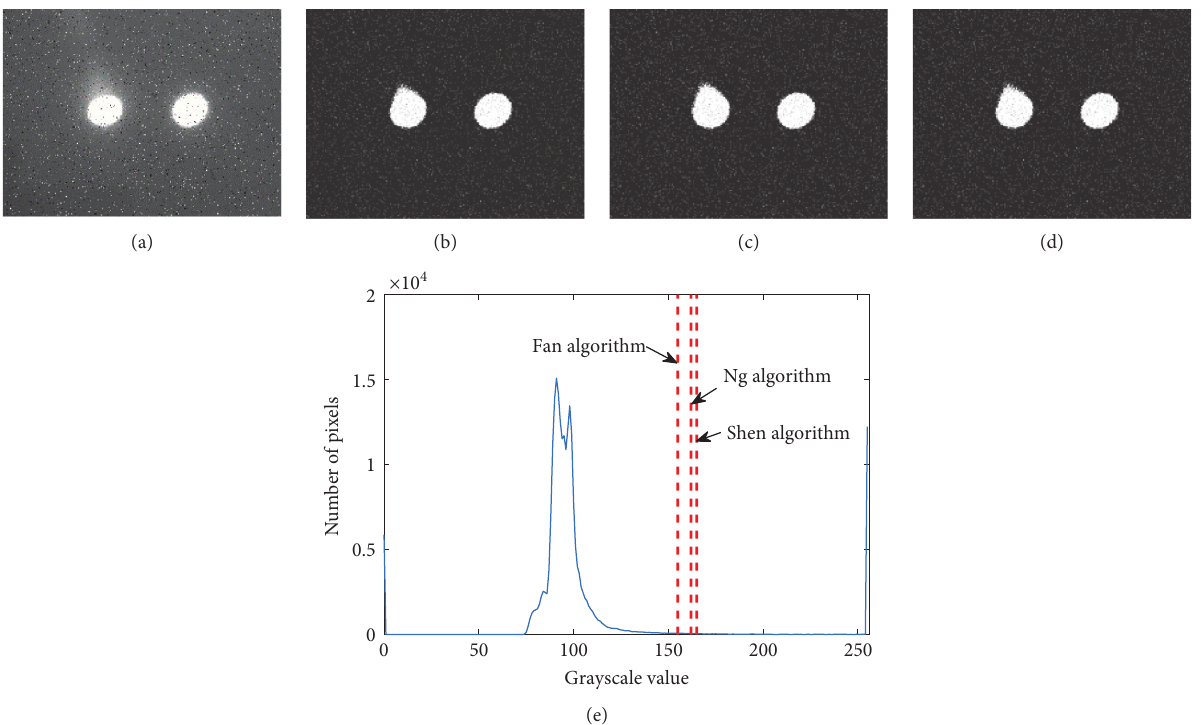
Figure 9: Laser speckle segmentation effect under the interference of pulse noise: (a) original image, (b) Ng algorithm, (c) Fan algorithm, (d) Shen algorithm, and (e) histogram and each segmentation threshold.